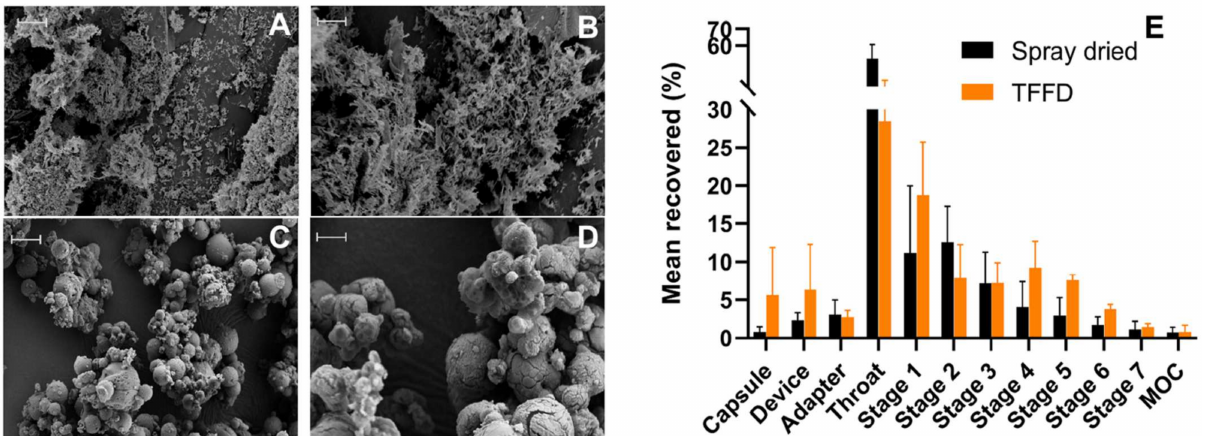
Figure 6. Representative SEM images of dry powders of SLNs prepared by thin-film freeze-drying ( A , B ) or spray drying ( C , D ). In ( A , C ), the scale bar indicates 10 µ m, and in ( B , D ), the scale bar indicates 2 µ m; ( B ) deposition patterns of dry powders of SLNs prepared by spray drying or thin film freeze-drying in NGI (MOC, micro-orifice collector). Data are the mean ± S.D. ( n = 3). Reproduced from Wang et al. [42] with kind permission of copyright holder,